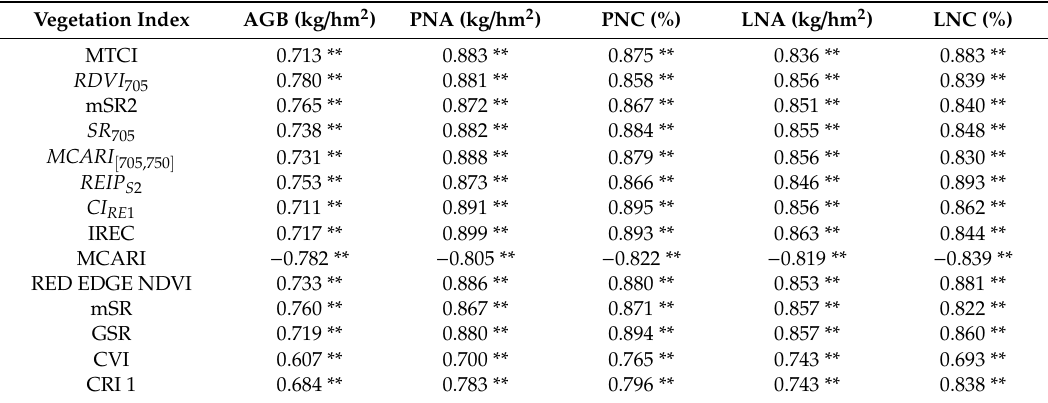
Table 5. Correlation between vegetation indices (VIs) and above ground biomass (AGB), nitrogen nutrition parameters for Trial 1 and Trial 2 ( n = 80).